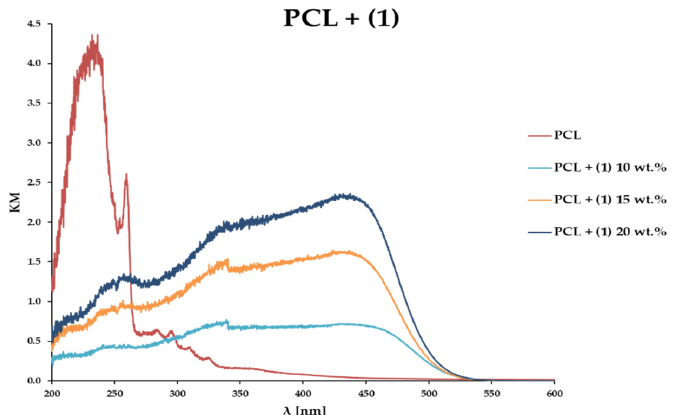
Figure 6. UV–Vis DRS spectra of PCL and studied PCL + ( 1 ) composites.